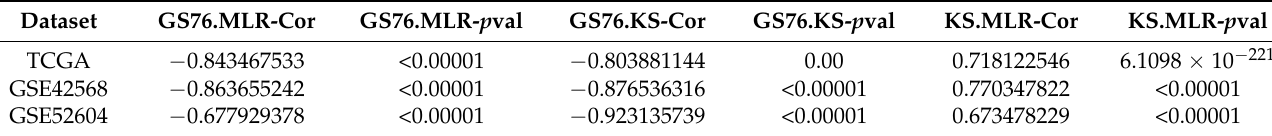
Table 9. Correlation between GS76, MLR and KS EMT scoring methods across samples.